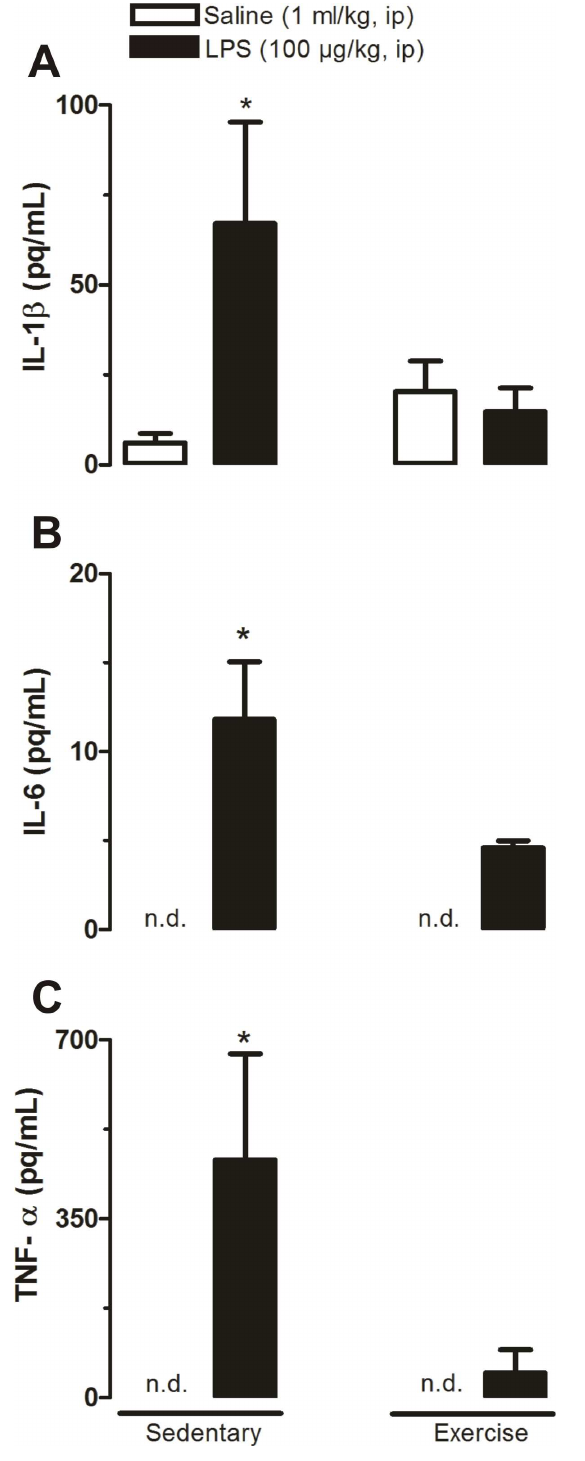
Fig 4. Plasma levels of IL-1 β (A), IL-6 (B) and TNF- α (C) at 120 min after systemicadministration of LPS or saline . Sedentarysaline(n = 8), SedentaryLPS (n = 6), Exercisedsaline (n = 5) and ExercisedLPS (n = 5). * P < 0.05,Sedentary LPS vs. the other three groups.